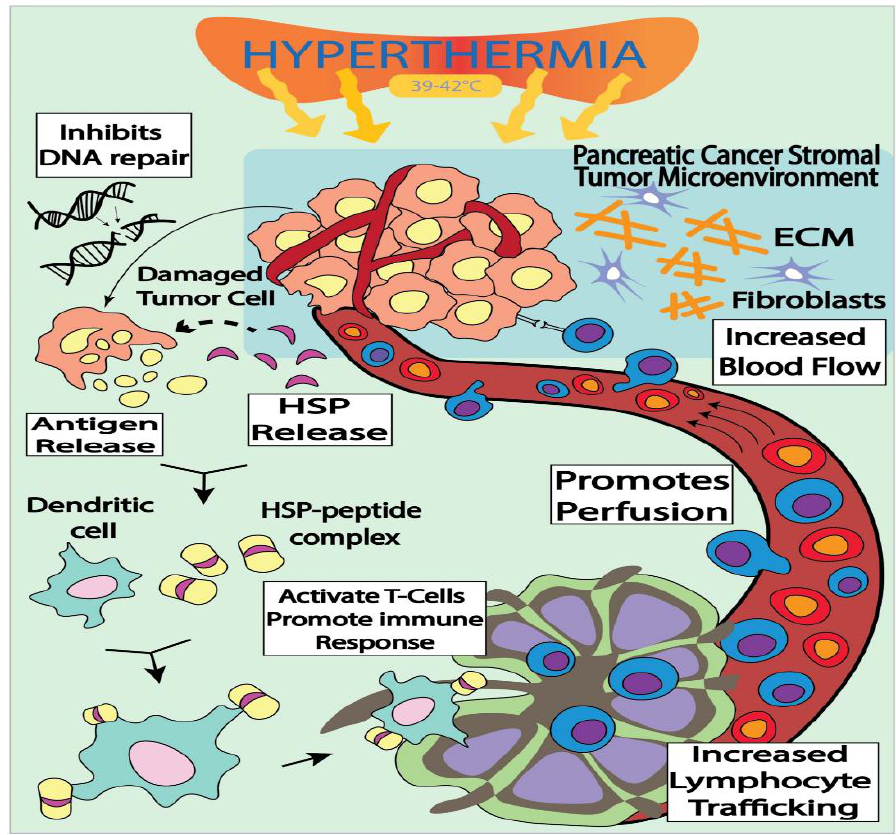
Figure 1. Integrated workflow of hyperthermia and its impact in activation of the immune response and inhibition of cancer cell DNA repair. Extra Cellular Matrix (ECM); Heat Shock Protein (HSP).